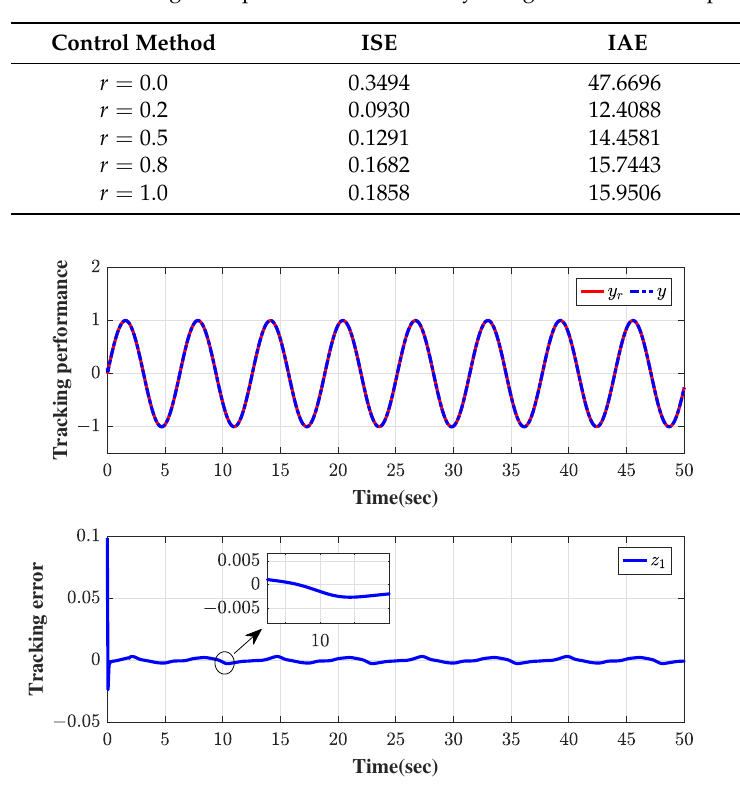
Table 2. Tracking error performance indices by using different control parameters.